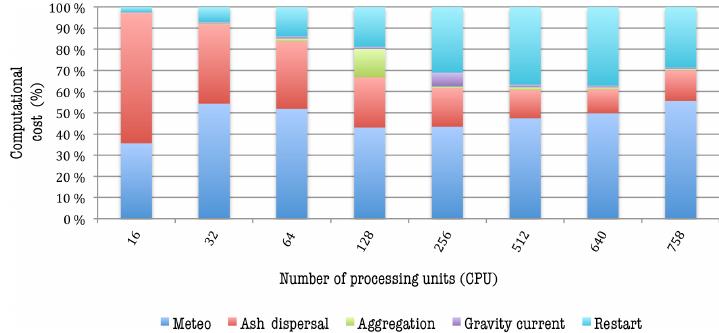
Figure 13. NMMB-MONARCH-ASH relative computational cost (%) with increasing CPUs. Represented processes include meteorology (blue), ash dispersal for 10 bins (red), aggregation (green), gravity current (purple); and restart (light blue).